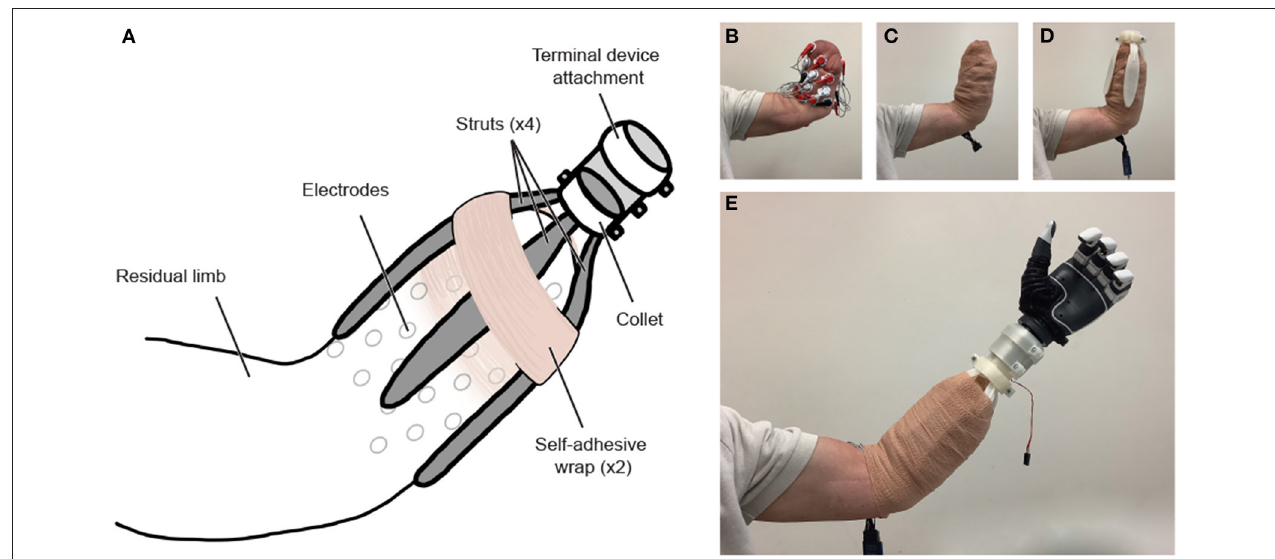
FIGURE 2 | (A) Functional-test socket overview. (B) The residual limb is outfitted with sEMG electrodes and (C) wrapped securely in a disposable adhesive bandage. (D) After being heated, molded, and cut to the desired length, the custom-fit struts are attached to the collet, and the socket is donned. (E) A second layer of adhesive bandage is wrapped around the limb and socket system, and the socket is fit with a myoelectric prosthesis, pictured above with a TASKA hand. The modular terminal device attachment is conducive to use with a variety of terminal devices. The 3D-printed components can be removed, reshaped, and reused with a subsequent individual without requiring